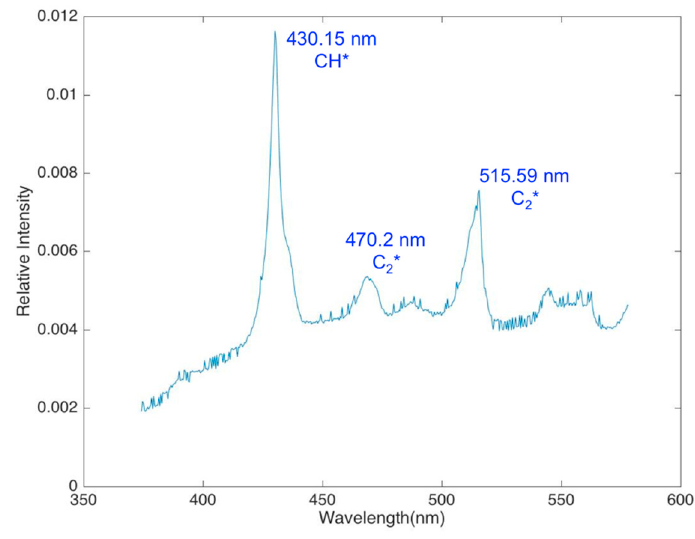
Figure 10. CH*(0,0), C2*(1,0), and C2*(0,0) emission bands of a methane hydrate flame.